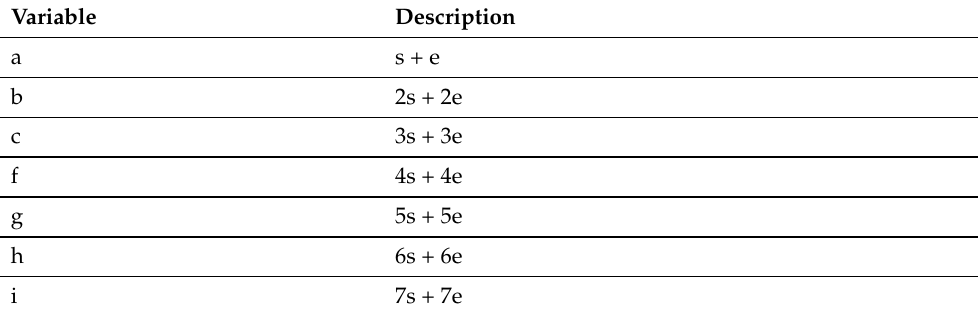
Table 3. Metrics Variables.